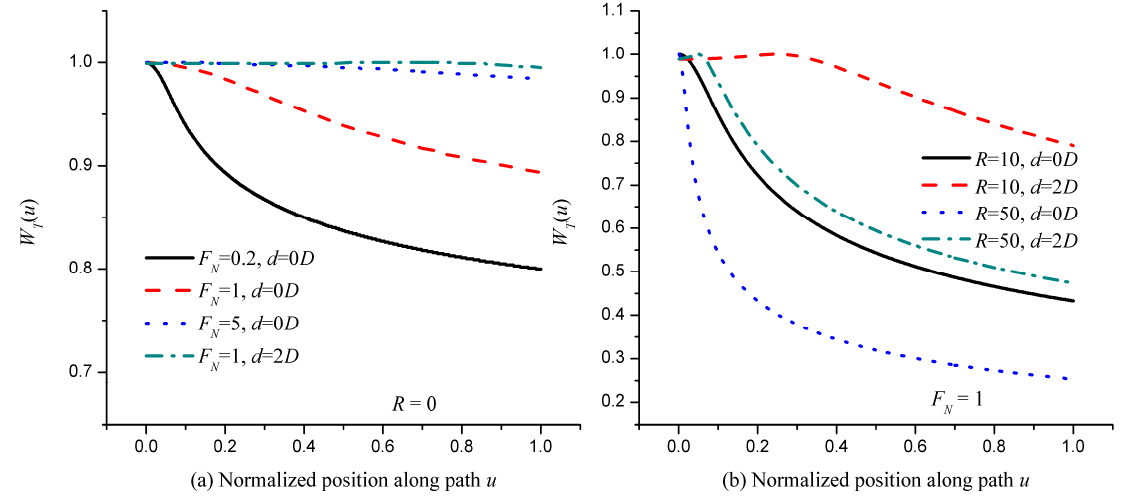
Figure 2. Normalized path-weighting function W T ( u ) for plane waves. ( a ) Point sources with various F N ( F N = D 2 / λ L ) and d (the distance between the aperture centers) values. ( b ) Distributed sources with various R ( R = D S L/DL S ) and d values when F N = 1.